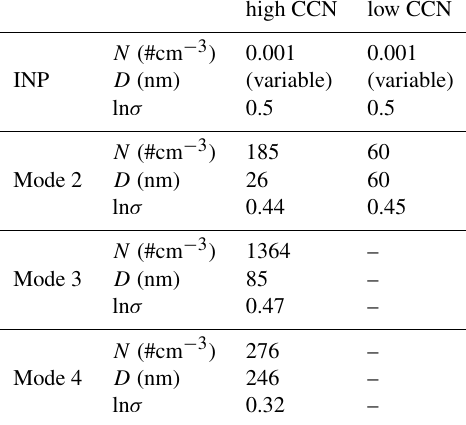
Table 3. Log-normal parameters for the aerosol in both “low CCN” and “high CCN” simulations. The “high CCN” aerosol are from Van Dingenen et al. (2004) from measurements taken during sum- mer months in the afternoon with only “natural” sources. Mode 1 in “low CCN” is made up of K-feldspar aerosol, (with varying soluble fraction made of ammonium sulphate) and mode 2 is ammonium